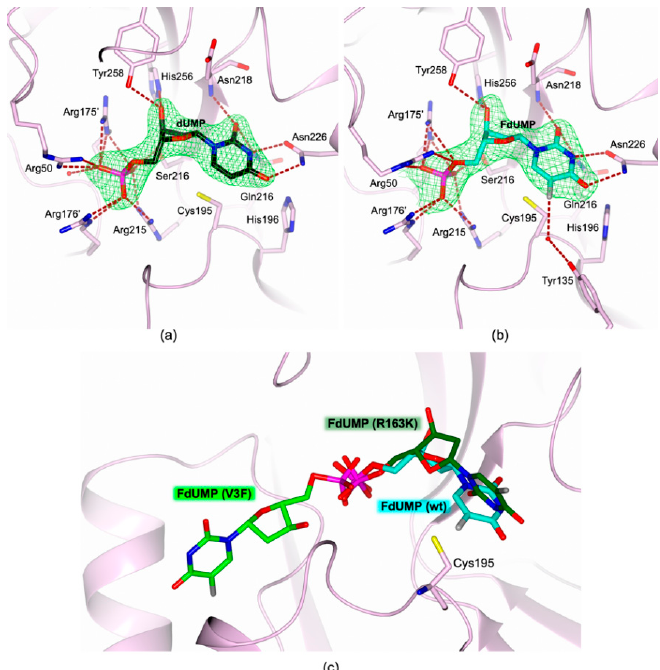
Figure 6. ( a , b ) Active site view of hTS (light pink cartoon and carbon atoms) in complex with ( a ) dUMP (in sticks, black carbon atoms) and ( b ) FdUMP (in sticks, cyan carbons). In both panels, the ligands are surrounded by the omit map (green mesh) contoured at the 2.5 σ level, and key interactions (salt bridges, hydrogen and halogen bonds) are displayed as tan dashed lines. ( c ) Different orientations of FdUMP in the complexes with the wild-type hTS (pink cartoon and carbon atoms, FdUMP in sticks, cyan carbons) and the variants R163K (FdUMP in sticks, dark green carbons; 3H9K [13]) and V3F (FdUMP in sticks, green carbons; PDB id 3EJL